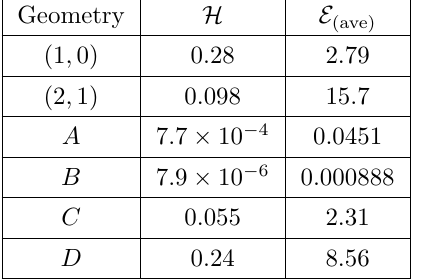
Table 3. The entropy parameter H (see (5.8)) and the average error between the direct BPS and the indirect methods (see (5.10)) computed for the six geometries we consider in this